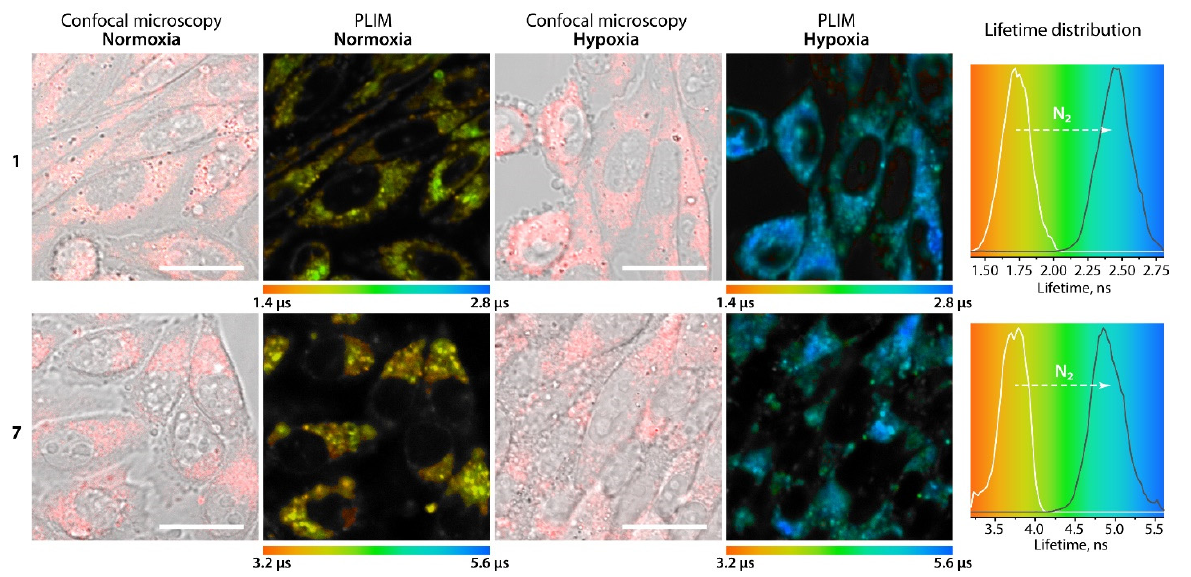
Figure 7. Confocal microphotographs and PLIM images of CHO-K1 cells incubated with complexes 1 (Top, 5 µM, 1.5% of PEG-200, 24 h) and 7 (Bottom, 10 µM, 2.5% of PEG-200, 24 h) under normoxia and hypoxia (induced by N 2 purging). Confocal images are presented as merged luminescence images and DIC (differential interference contrast). In PLIM, colors correspond to the lifetime in the range of 1.4–2.8 µs for 1 and 3.2–5.6 µs for 7 . Lifetime distributions are calculated for thew whole PLIM images. Excitation 405 nm, 37 °C and 5% CO 2 .